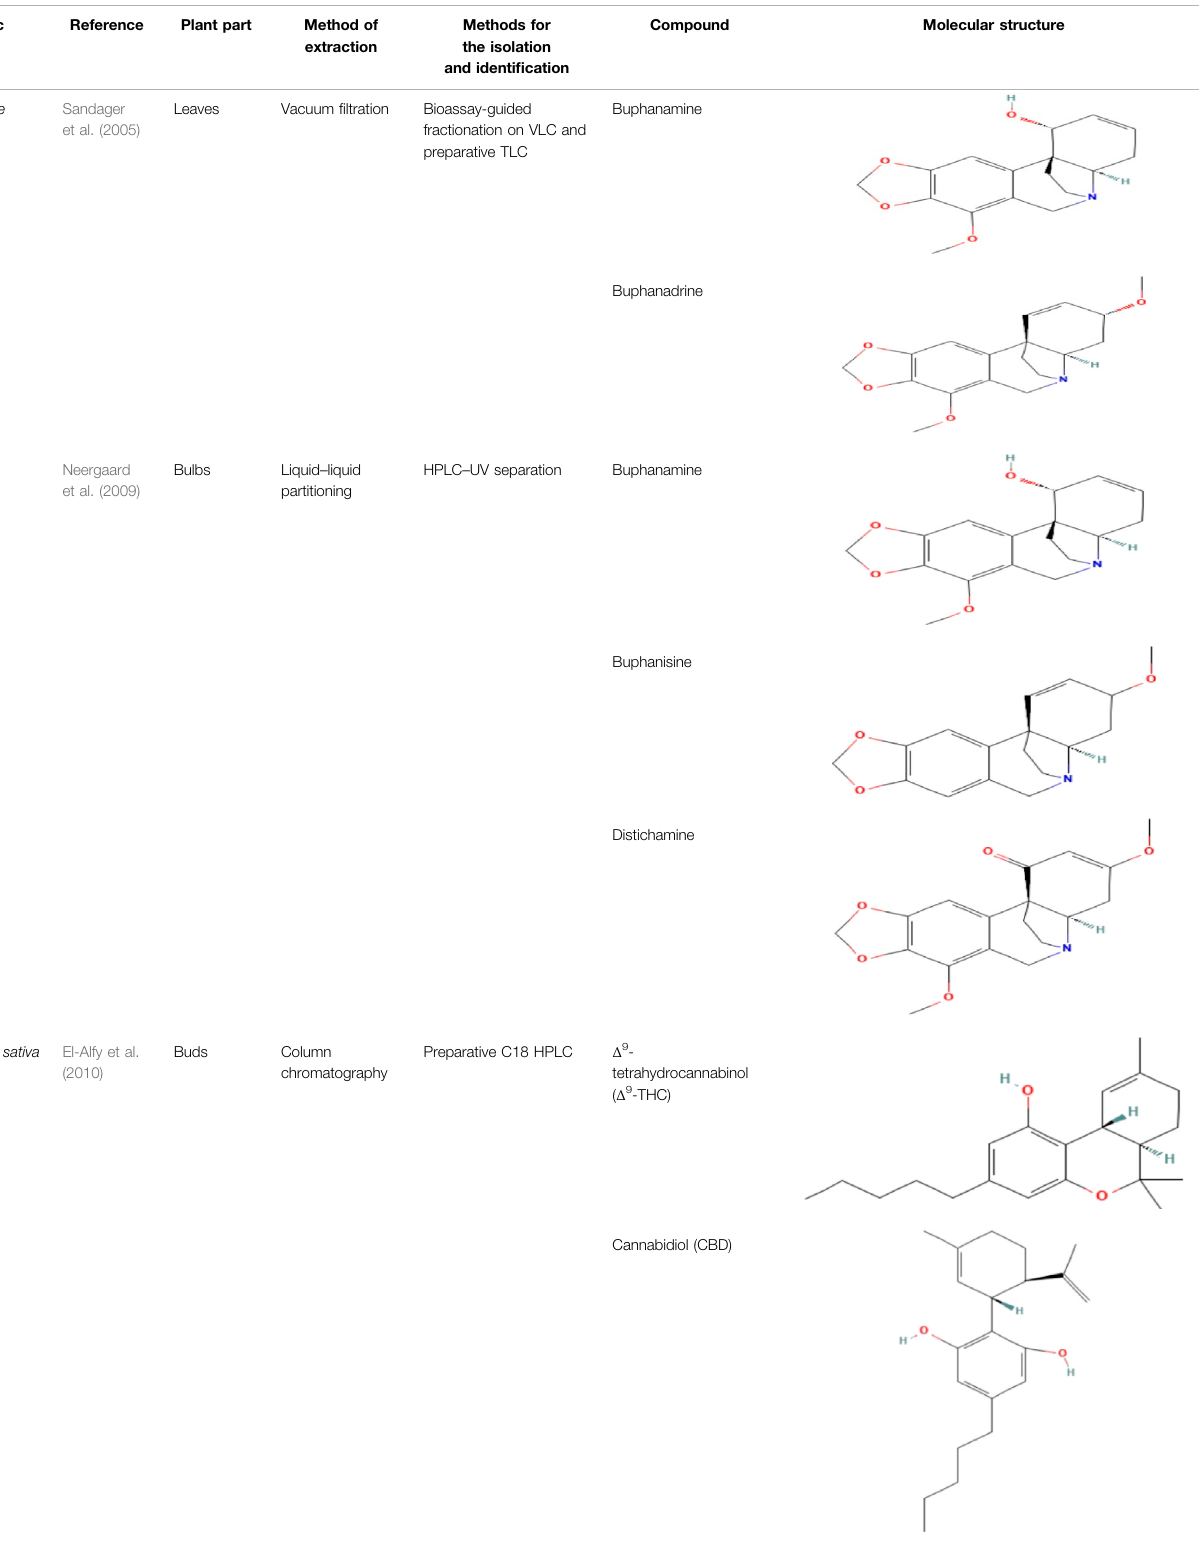
TABLE 3 | Phytochemicals isolated and chemical structures of compounds from plant with antidepressant-like